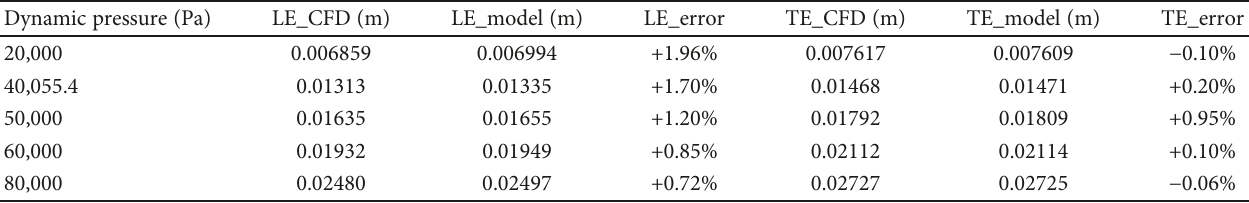
Table 7: The comparison of the displacement of the wing tip by the CFD/CSD method and modeling method. Dynamic pressure (Pa) 40,055.4